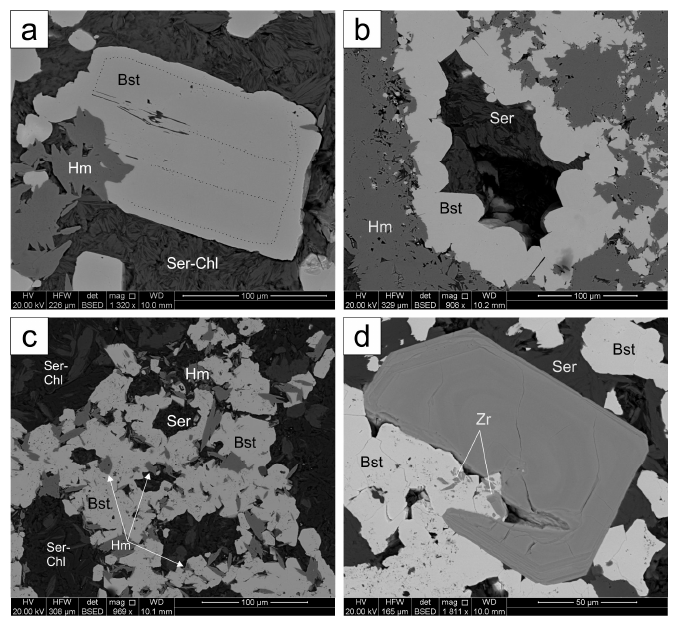
Figure 3. BSE images showing textural aspects of stubby matrix bastnäsite: ( a ) Individual stubby bastnäsite (Bst). Black line outlines pattern of hematite (Hm) and sericite (Ser) inclusions (sample RX6728). Chl-chlorite; ( b ) Stubby bastnäsite along margins of cavity with open space filled by sericite (sample RX6728); ( c ) Stubby bastnäsite forming a cement to other matrix minerals (sample RX6710); ( d ) Zircon (Zr) enclosed and partially replaced by bastnäsite cement (sample RX6709).